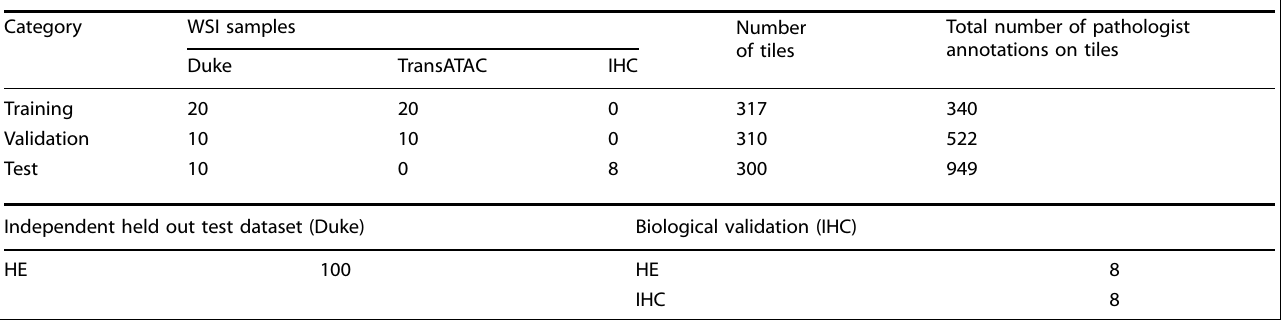
Table 1. Breakdown of training and validation tiles used in annotations of